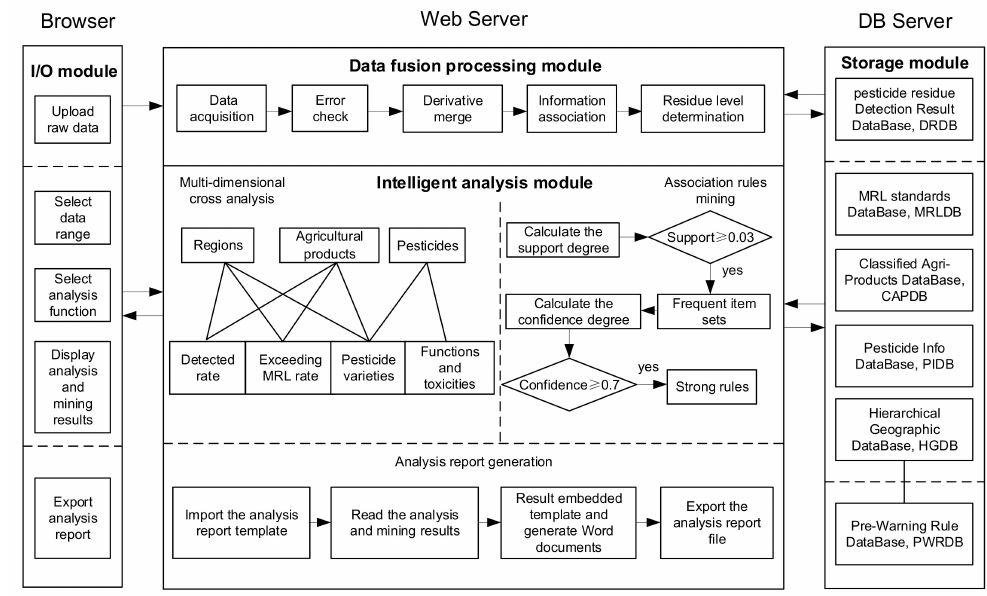
Figure 1. Framework of intelligent analysis system for Pesticide residue detection